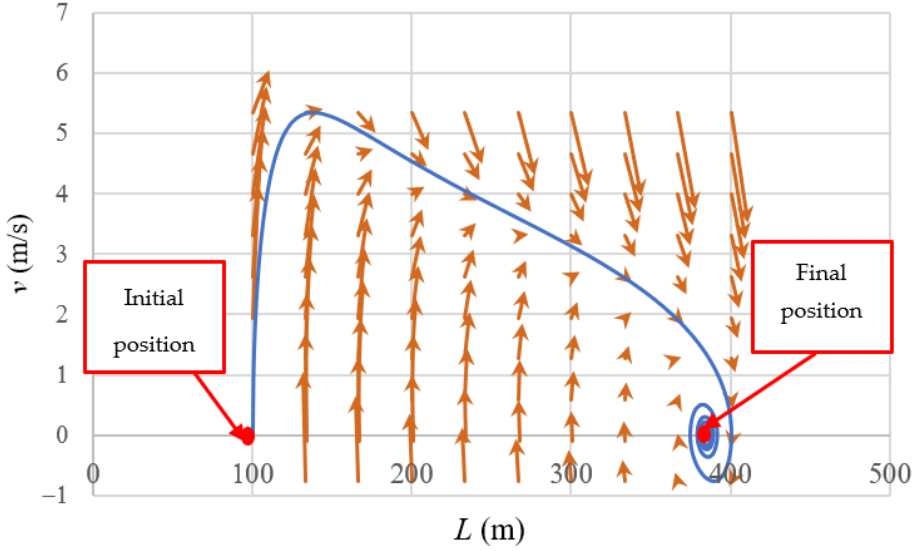
Figure 4. Relationship between water velocity and filling water column position.